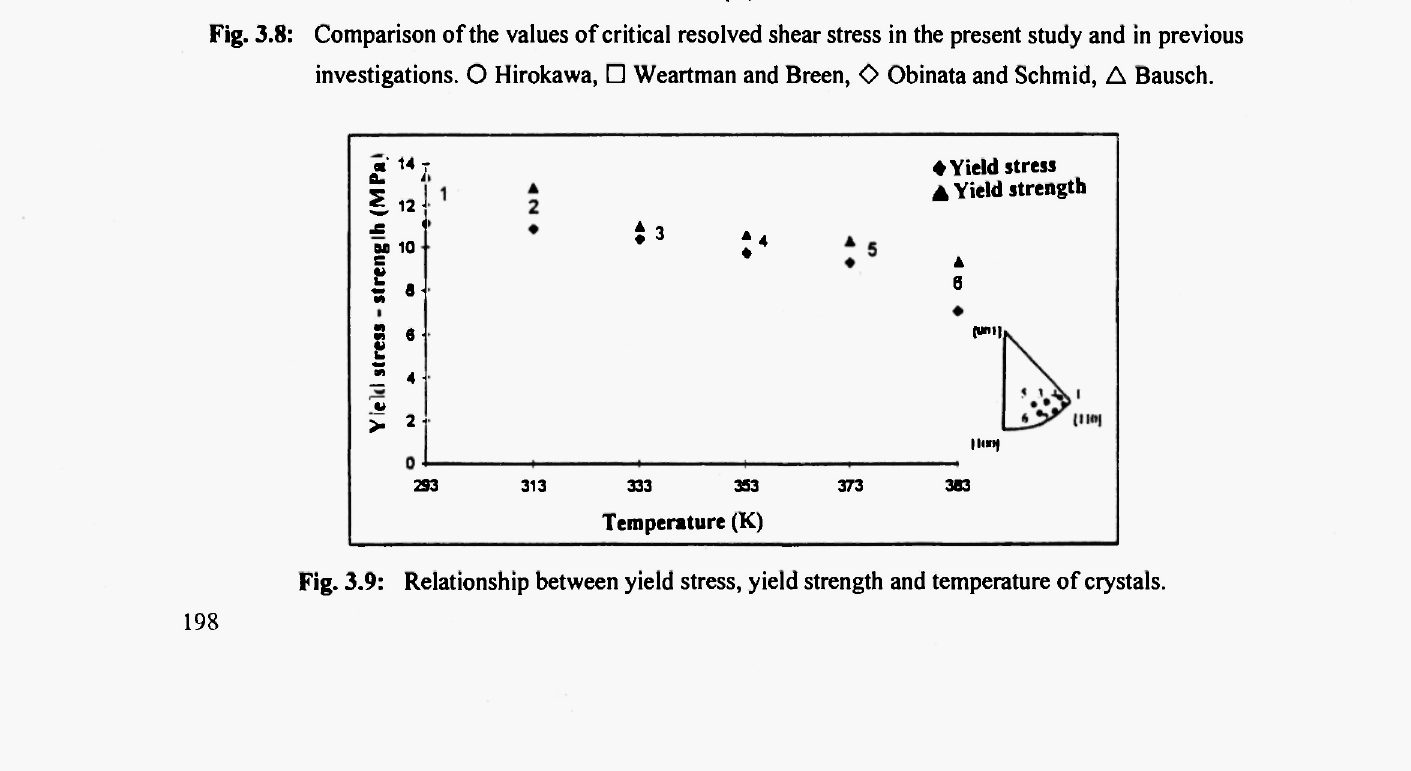
Fig. 3.8: Comparison of the values of critical resolved shear stress in the present study and in previous